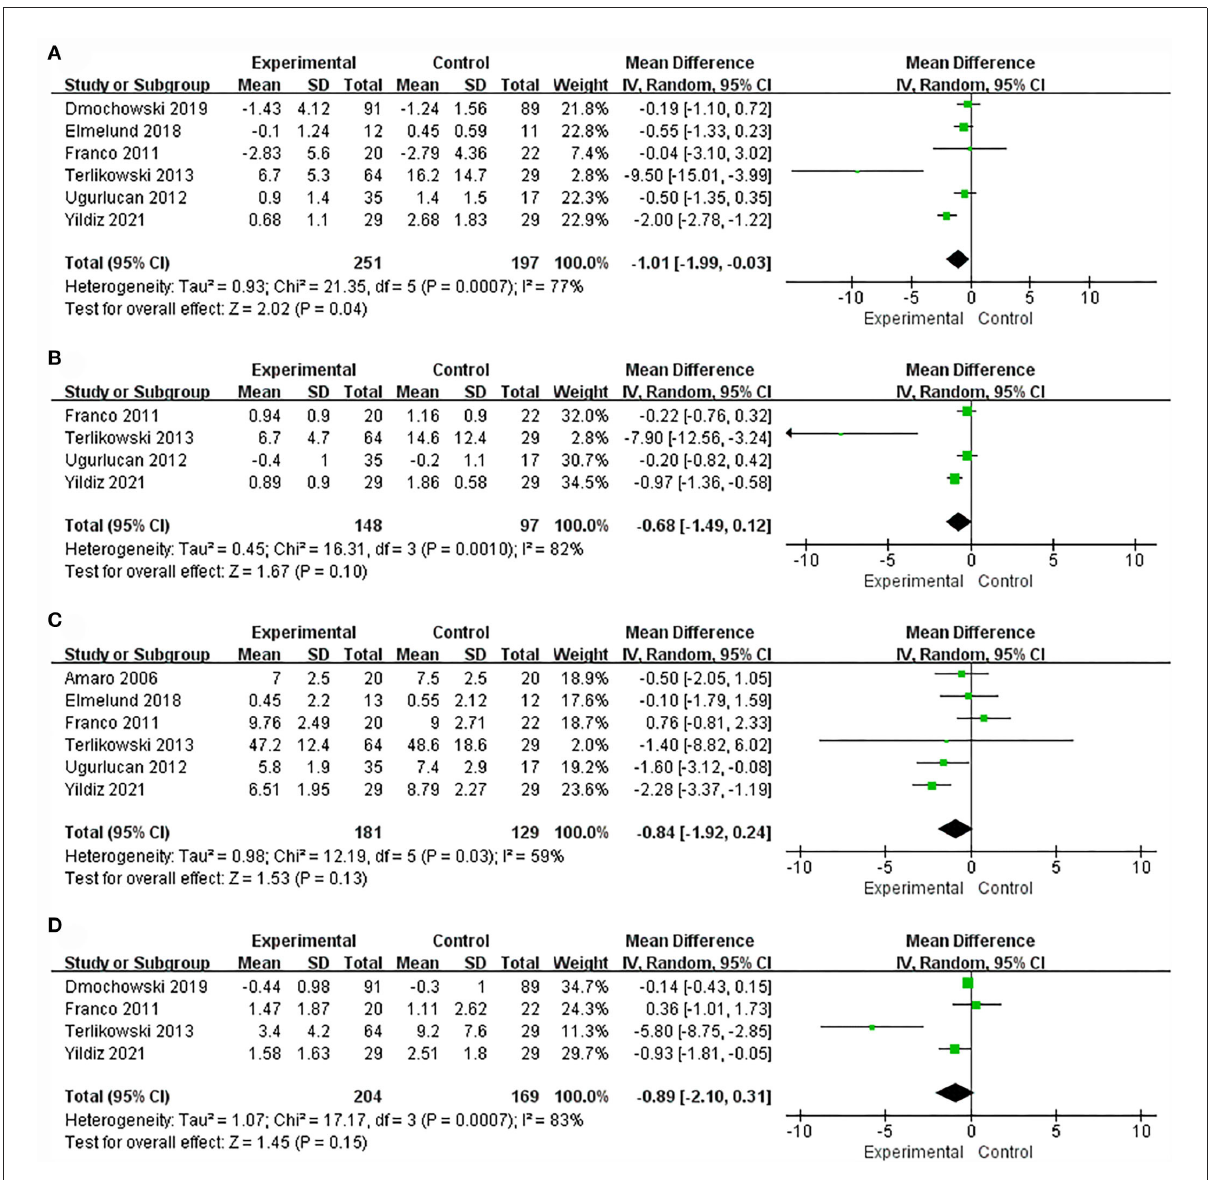
FIGURE5 Forest plots showing the changes in bladder diary after IVES treatment. (A) Incontinence episodes; (B) Nocturia; (C) Daytime micturition; (D) Number of urine pads. SD, standard deviation; IV, inverse variance; CI, confidence interval; df, degrees of